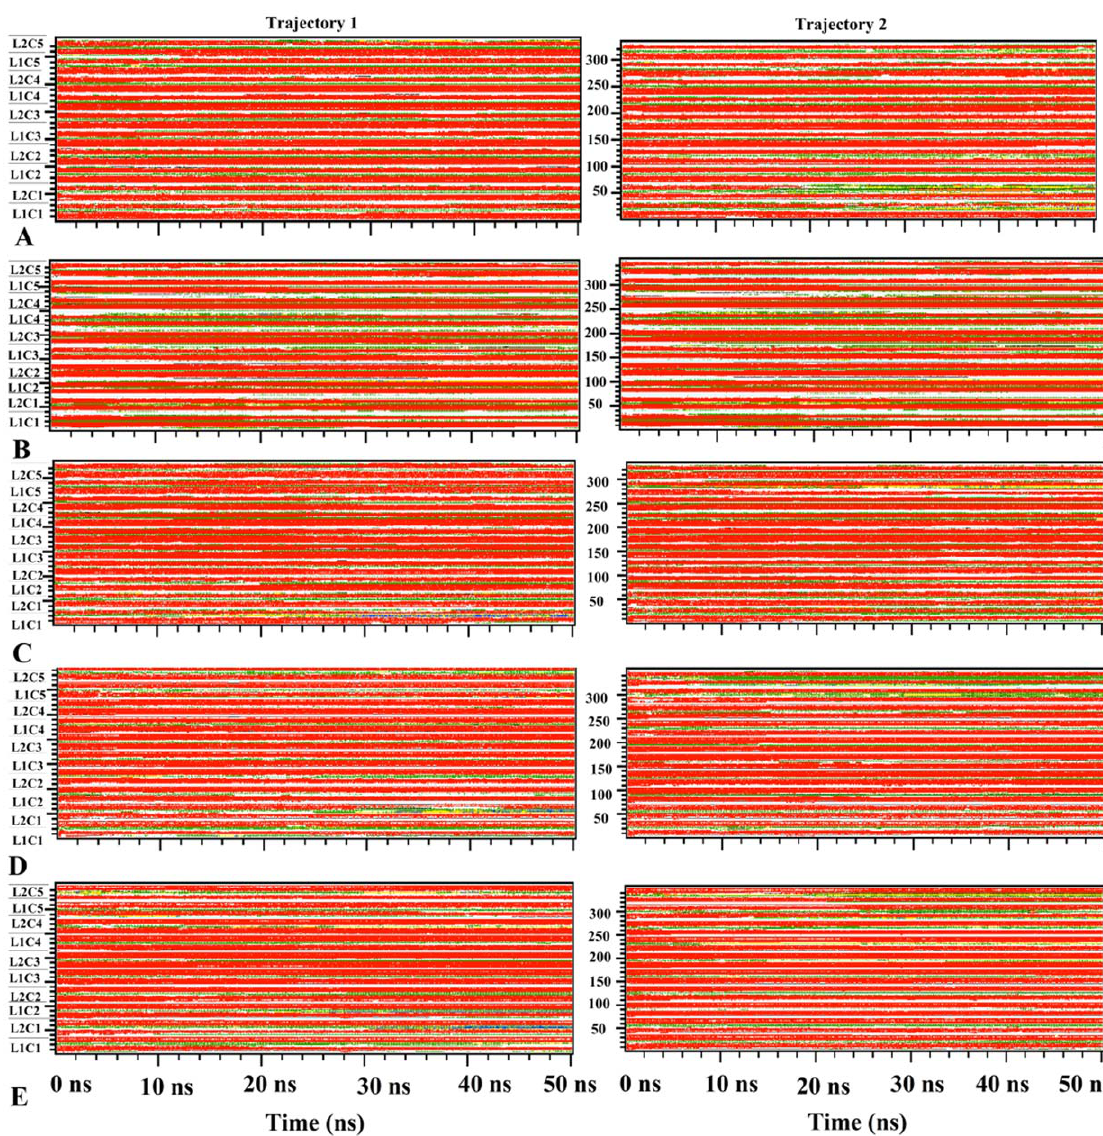
Figure 10. Secondary structure variation plot for each of the A b segmental polymorphism models. (A) A b 16 2 21 P, (B) A b 16 2 21 AP (C) A